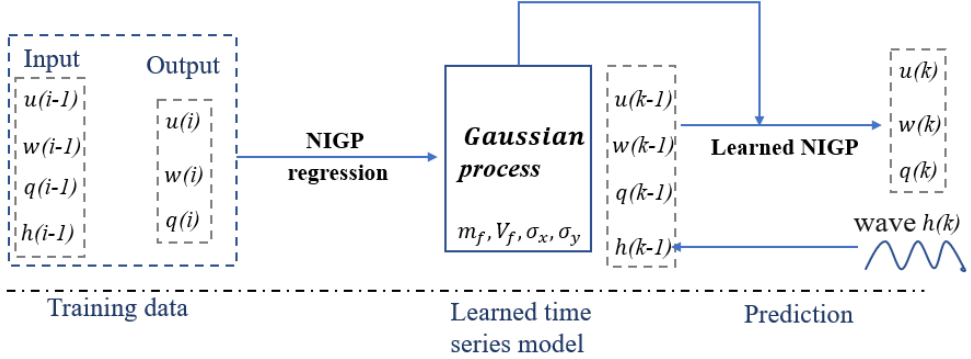
Figure 8. Process of black-box modeling of the WEC using NIGP.